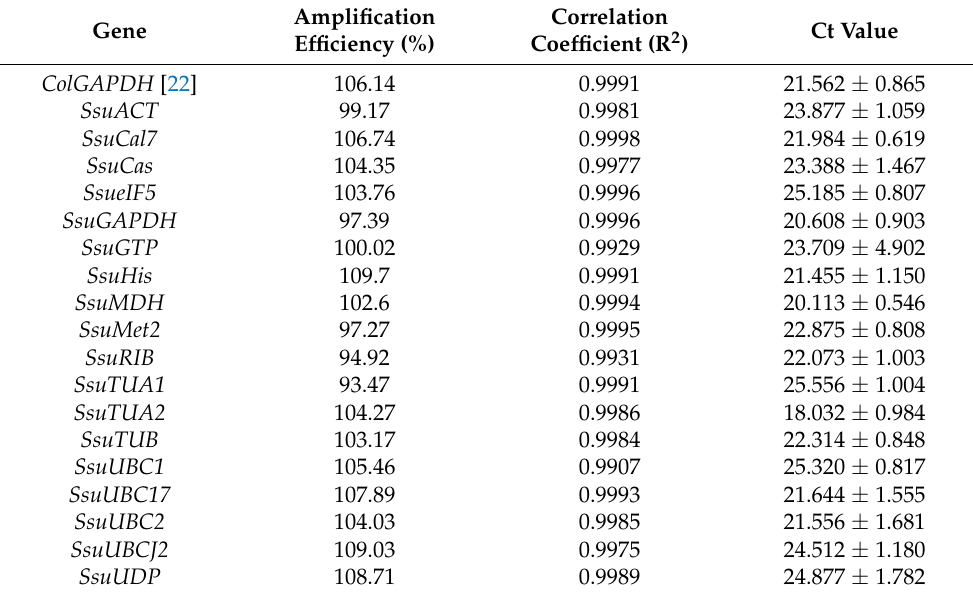
Table 1. Amplification efficiency and correlation coefficient of candidate reference